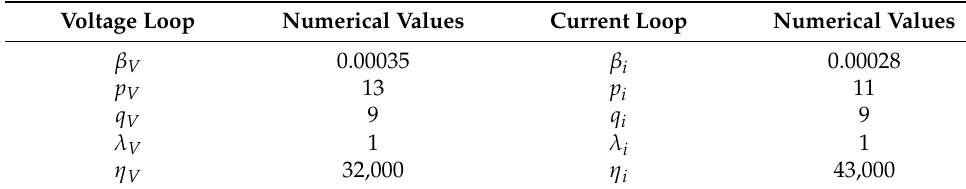
Table 2. Parameters of the proposed NTSMC for tracking voltage and current